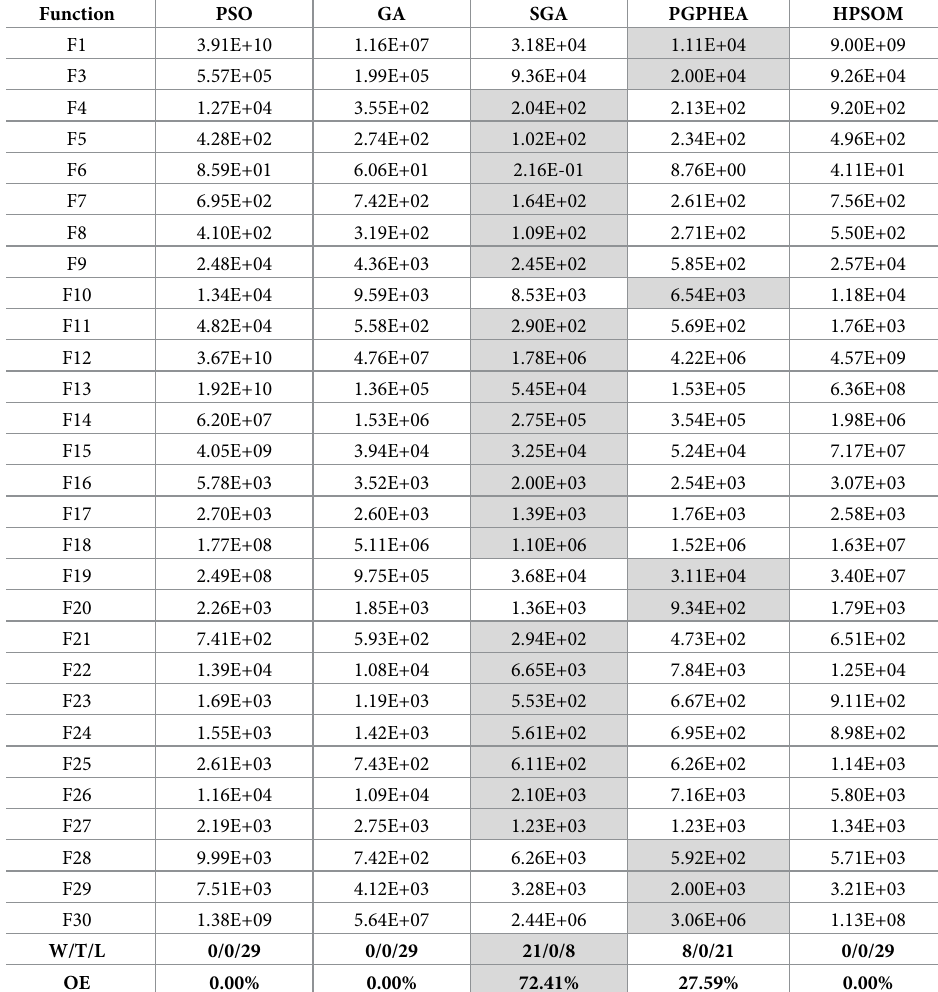
Table 8. Comparison of maximum error in finding global optimum for CEC 2017 problems.